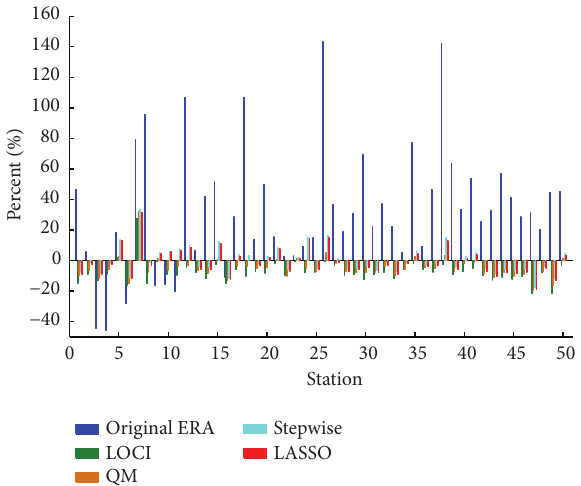
Figure 7: Percentage of annual precipitation bias between observations and the four downscaled results, as well as the original ERA-Interim data in the validation period 1999–2010.